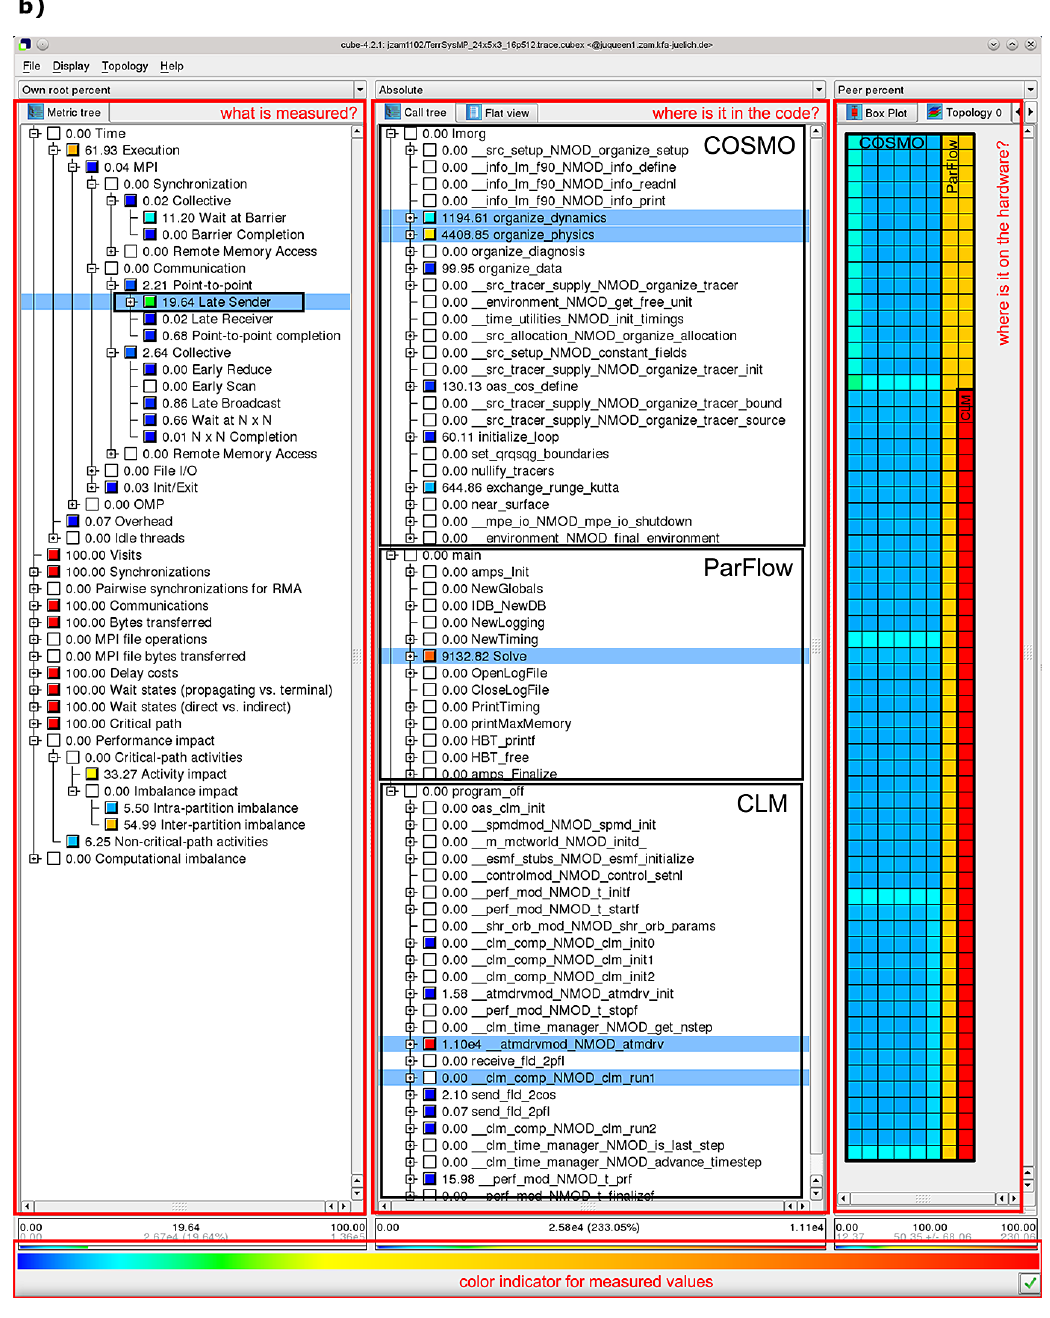
Figure 3b. The resources are distributed according to load; thus, the LateSender wait state is significantly reduced (processor distribution: 384 COSMO, 80 ParFlow, 48 CLM). The topology view shows fewer cores with LateSender wait states where receivers are waiting for senders in the relevant functions. The unit of the middle view is LateSender waiting time (accumulated over all CPUs). The units in the left and right view are